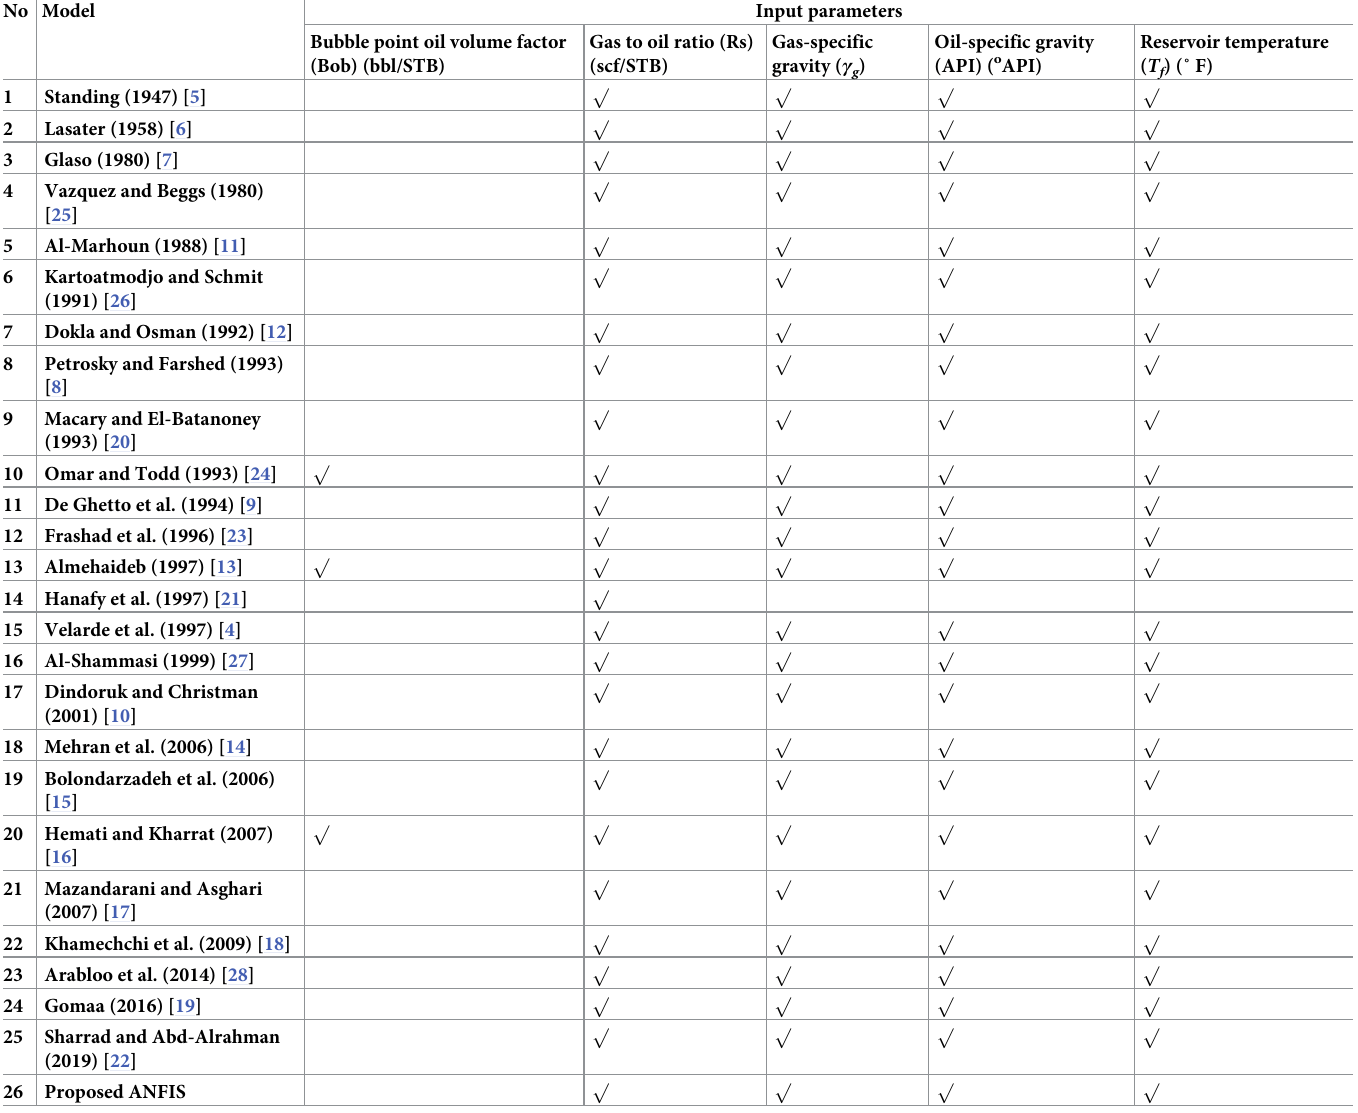
Table 1. Comparison of input parameters used in the published correlations and the proposed ANFIS model. No Model Input parameters Bubble point oil volume factor Gas to oil ratio (Rs) (Bob) (bbl/STB)